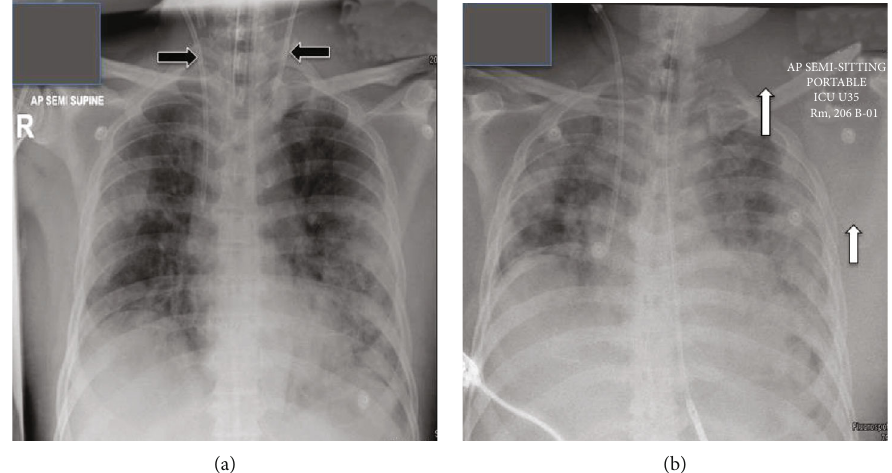
Figure 1: (a) Chest X-ray showing two double lumen hemodialysis central vascular access. (b) Chest X-ray after the removal of the one on the left side with signi fi cant soft tissue swelling around the left shoulder associated with left lateral displacement of the scapula.